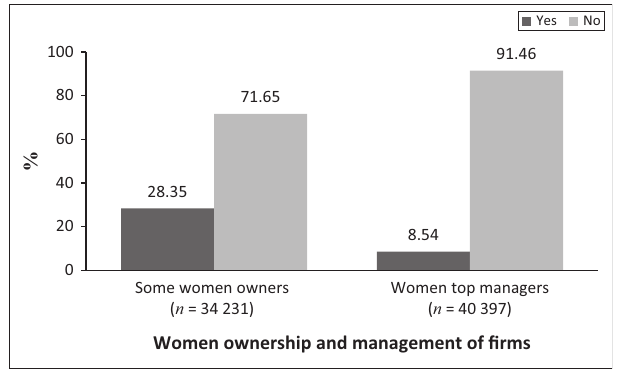
FIGURE 3: Distribution of firms’ adoption of digital technologies. Source : Authors’ computation based on data from World Bank. (2020). Enterprise surveys: Indicator descriptions. The World Bank . Retrieved from https://www.enterprisesurveys.org/